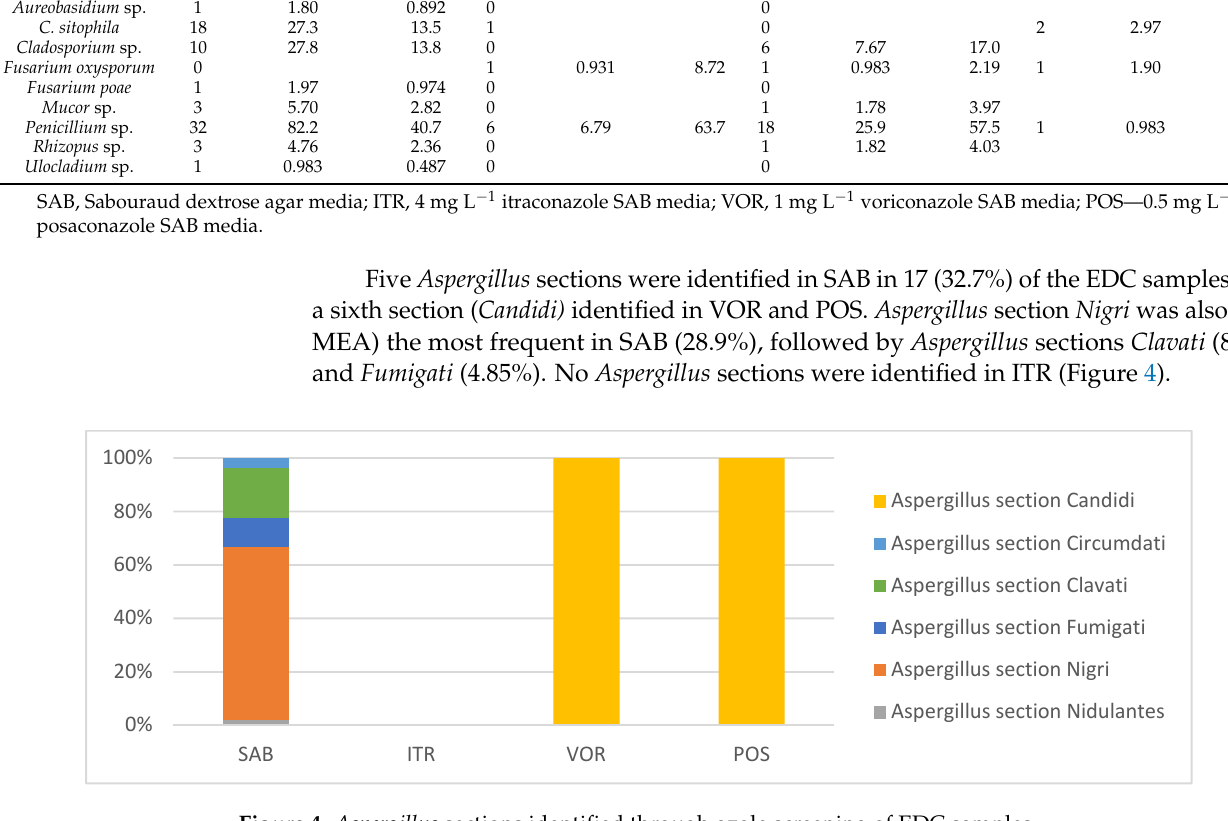
Figure 4. Aspergillus sections identified through azole screening of EDC samples.